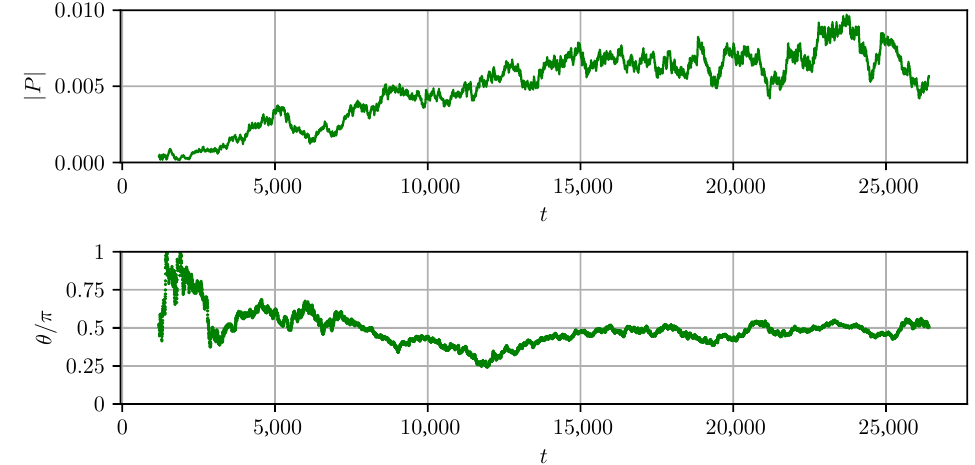
Figure 2. Time dependence of the momentum modulus and angle. f =